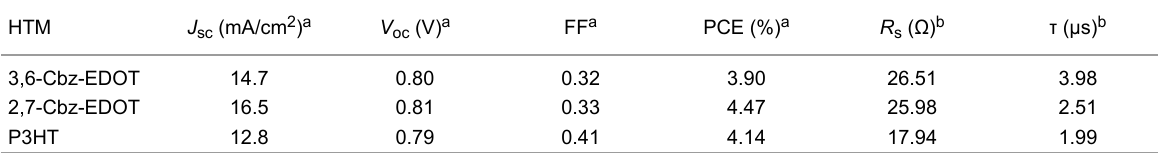
Table 2: Photovoltaic parameters of PSCs based on 3,6-Cbz-EDOT, 2,7-Cbz-EDOT, and P3HT. HTM